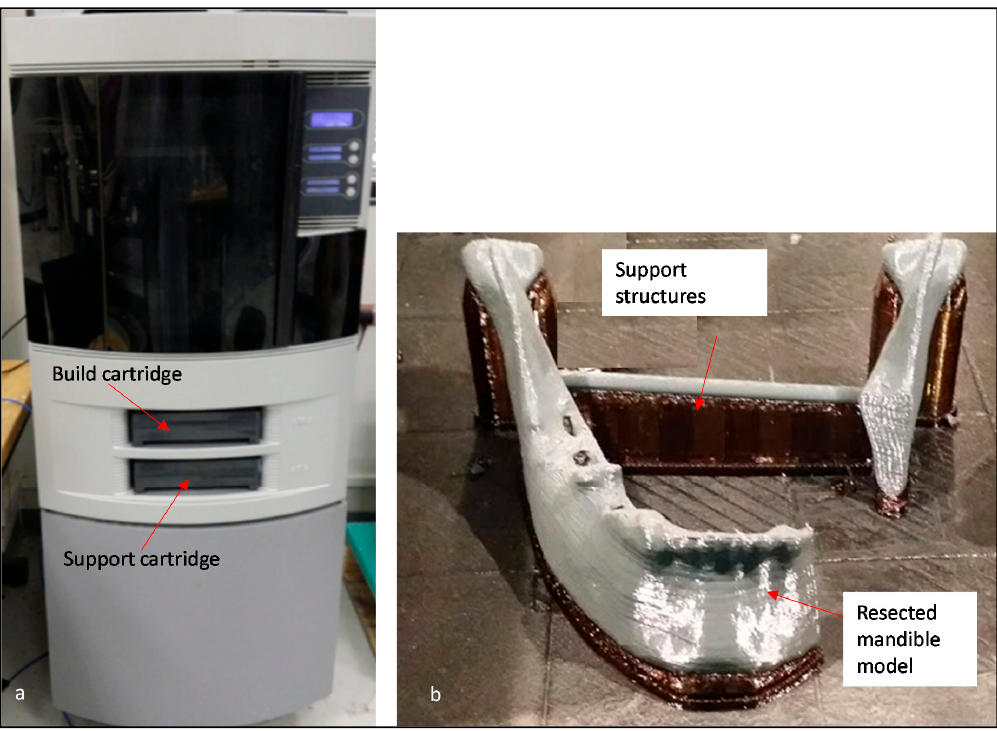
Figure 8. Fused deposition modeling (FDM) machine ( a ) with built resected mandible model, and ( b ) with support structures.